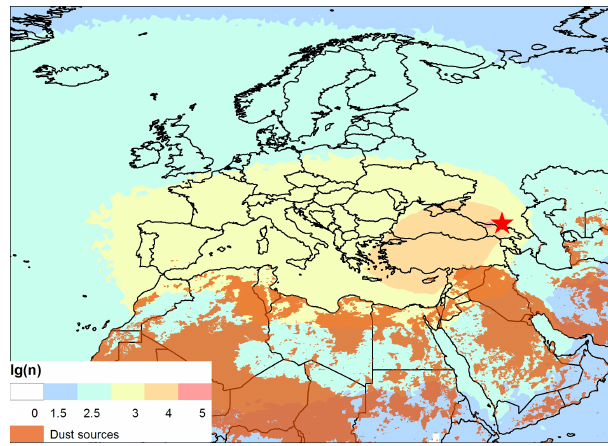
Figure 1. Location of Elbrus (red star) and dust sources (orange polygons) based on Ginoux et al. (2012). Annual NOAA HYS- PLIT_4 10d backward trajectory density plots for the period 1948– 2013 using NCEP/NCAR Reanalysis. Trajectories were run every